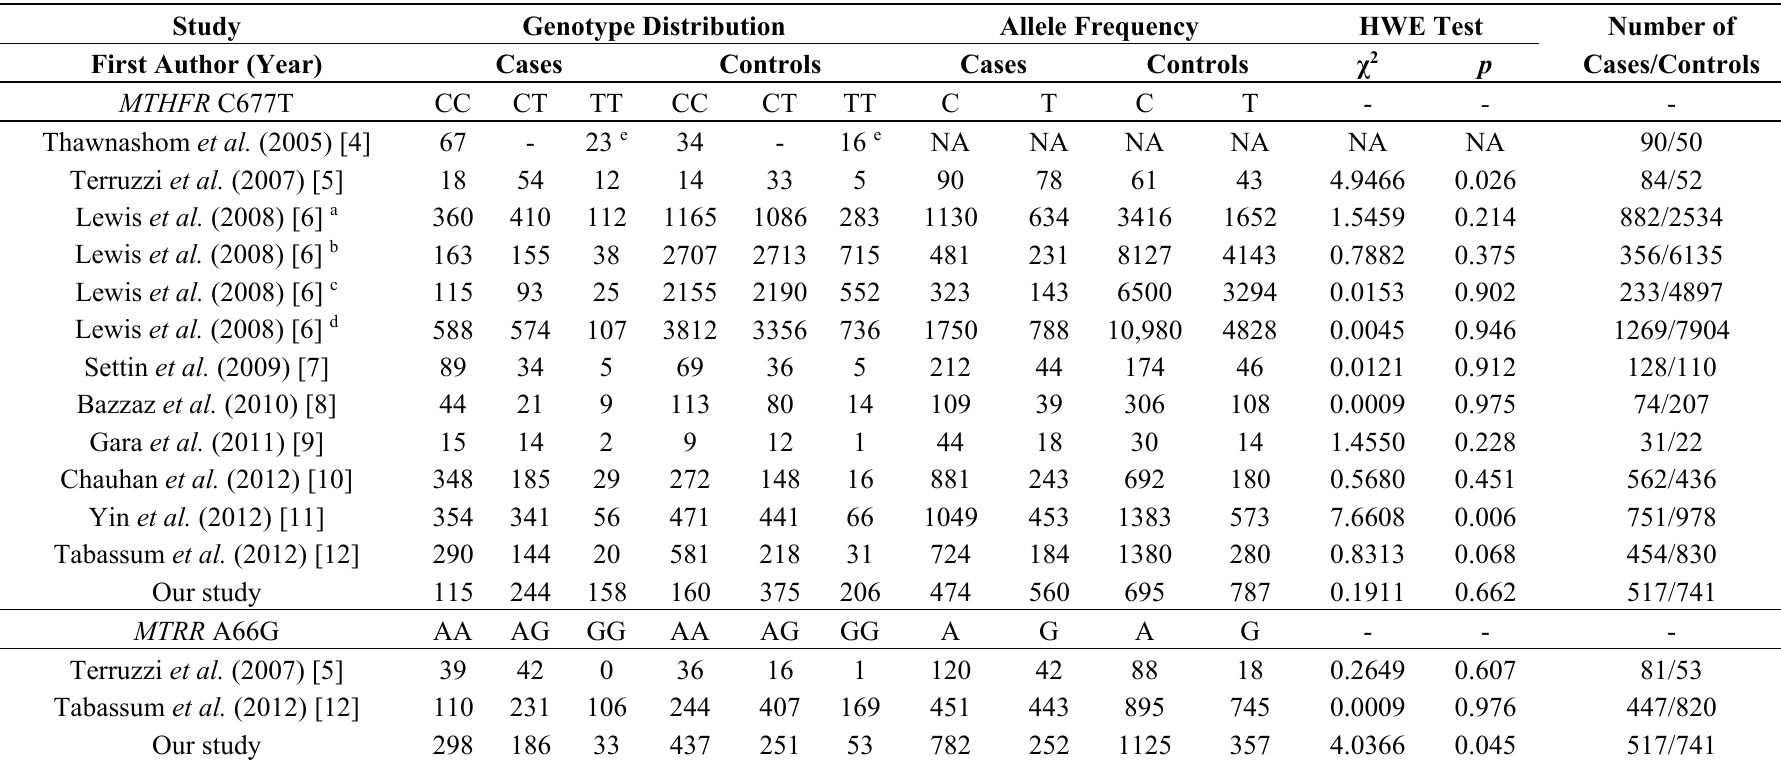
Table 3. Genotypic and allelic distributions of MTHFR C677T and MTRR A66G polymorphisms used in the